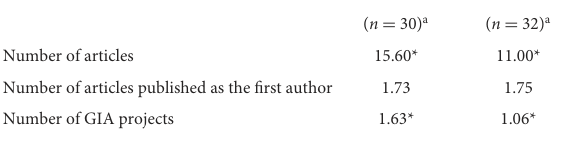
TABLE 2 Performance of researchers (mean values) during